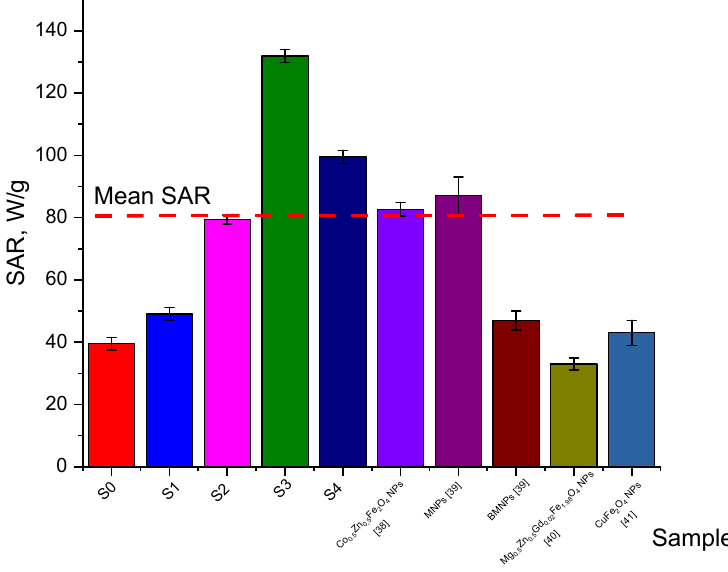
Figure 10. Results of a comparative analysis of the SAR value efficiency.